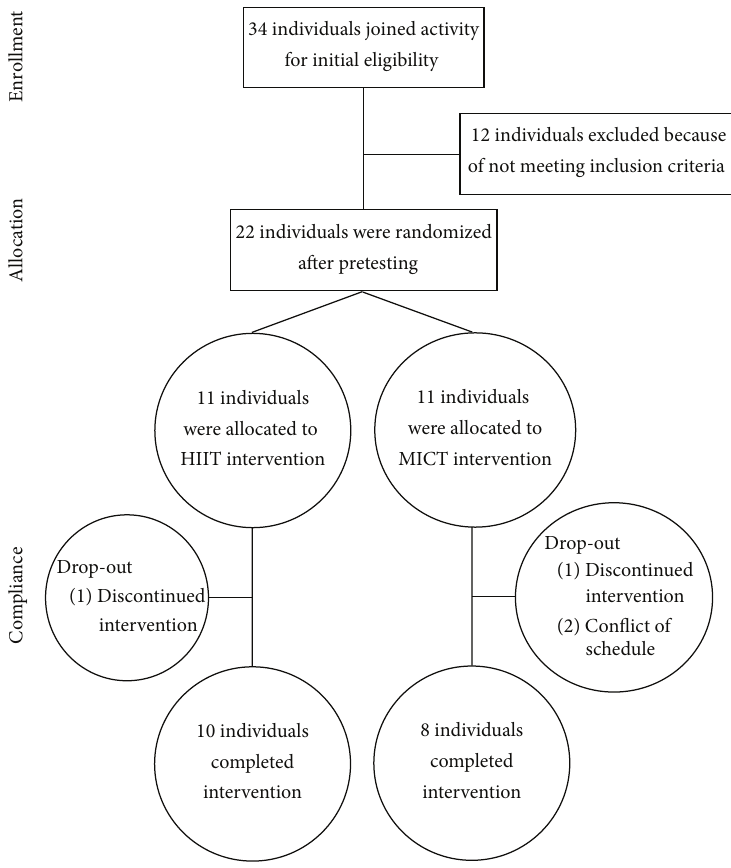
Figure 1: Flow of participants through the intervention of the